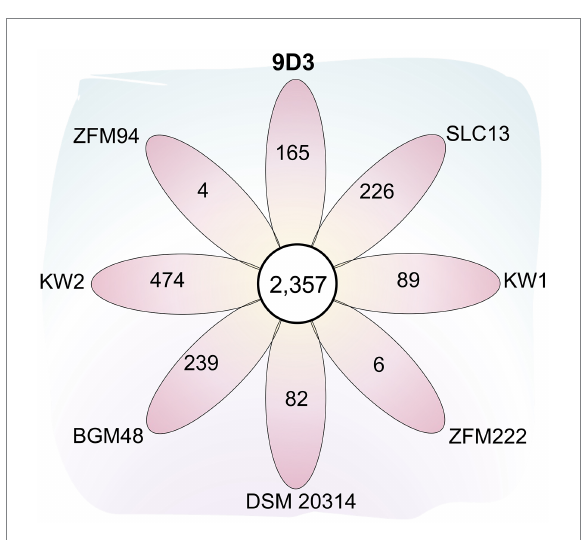
FIGURE 5 Flower plot diagram showing the numbers of core and unique genes among eight L. pentosus strains. The central circle shows the number of core gene families common to all strains while the petals show the numbers of genes unique to each strain. Abbreviated strain names are given outside each